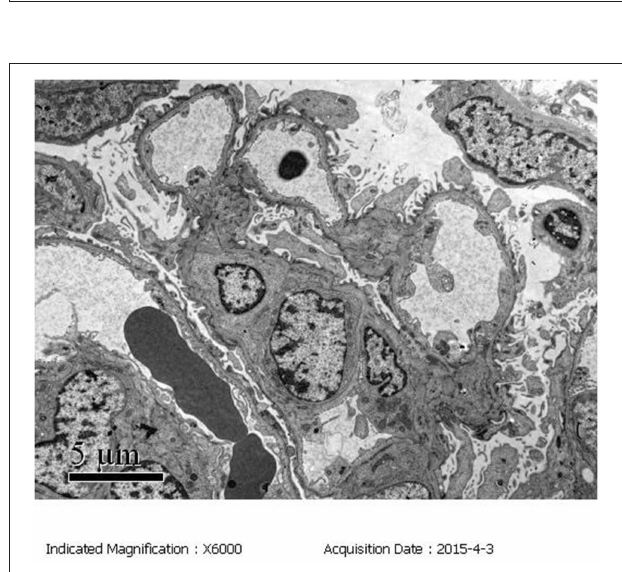
FIGURE 3 | Electron microscopy (EM) of the kidney biopsy specimen. The mesangial cells and matrix exhibited mild hyperplasia. The epithelial foot processes were fused with no electron dense